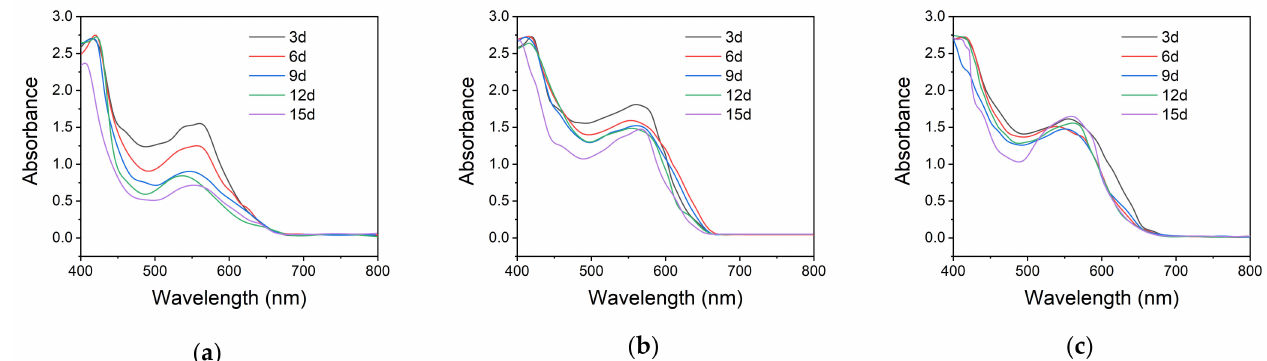
Figure 12. The absorbance of the microcapsules with different content of HALS 770 during the UV accelerated aging test. The content of HALS 770 in the microcapsules: ( a ) 0; ( b ) 10%; ( c )